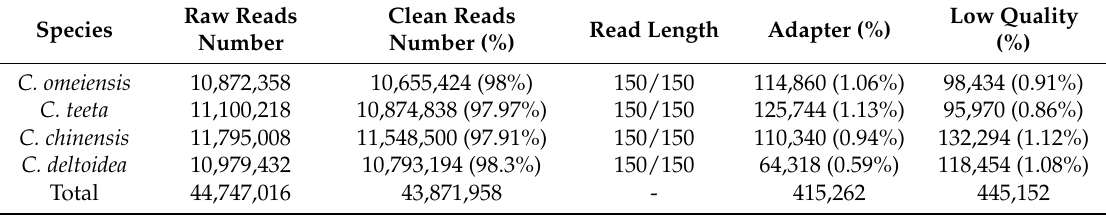
Table 3. Number of reads retained after initial quality filtering process for each Coptis plants sequenced.